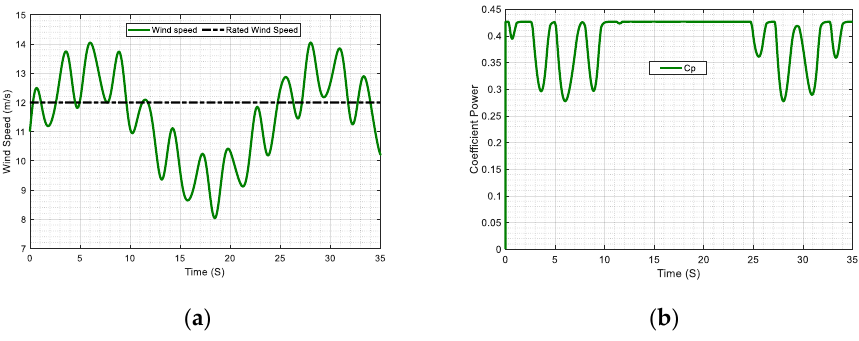
Figure 8. ( a ) Wind speed ( 𝑉 𝑤 ) profile; ( b ) power coefficient ( 𝐶 𝑝 ).